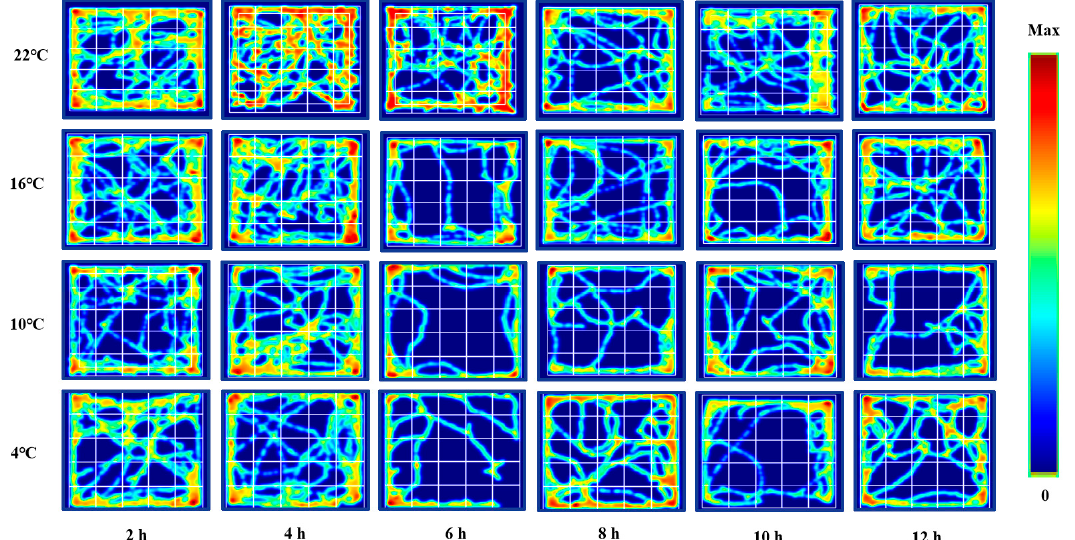
Figure 5. Movement trajectory map of mice in open field test under different intensity of cold exposure. 3.3. Changes in Anxious Mood of ICR Mice in Elevated Plus Maze Test under Different Inten- sity of Cold Exposure